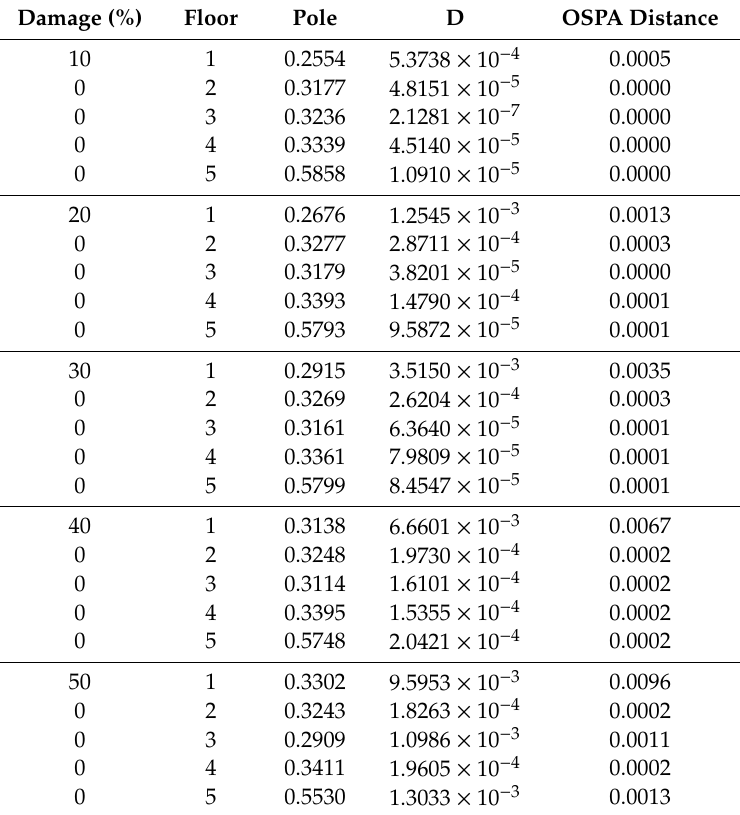
Table 2. OSPA distance and the corresponding parameters for the case of damage occurring on the first floor (El Centro earthquake excitation, 5% noise, autoregressive model, data length = 4000, AR order = 1, OSPA.p = 2, Assignment =